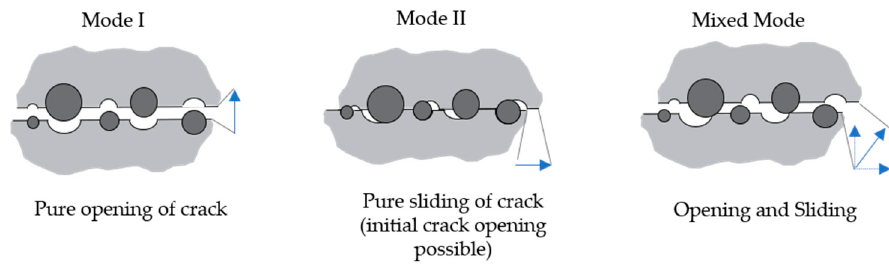
Figure 1. Illustration of the different crack modes according to Classen et al. [1].